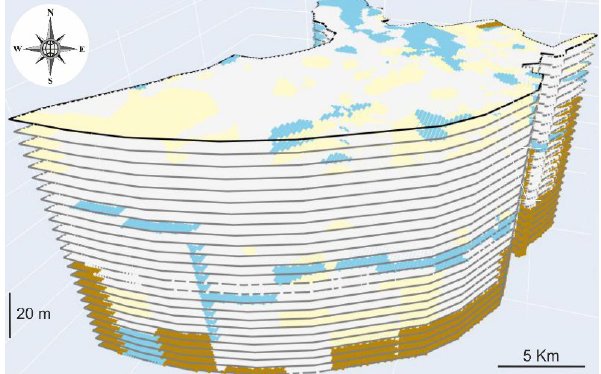
Figure 5. The consecutive 5 m-equispaced set of horizontal layers of the granulometry classes created with the KNN algorithm from 0 to 120 m b.s.l. in the onshore LRD. The color assigned to each granulometry class is cyan for gravel, yellow for coarse sand, light-grey for clay–silt and brown for the basement. An interactive 3D HTML version of this model is included in Supplementary